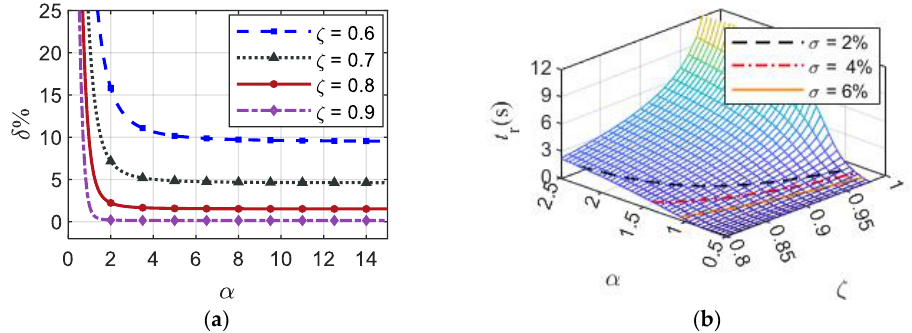
t ,  , and  ( a ) The relationship of  ,  , and  ; ( b ) The Figure 3. The relationship of  , r t ,  , and  . relationship of  , r